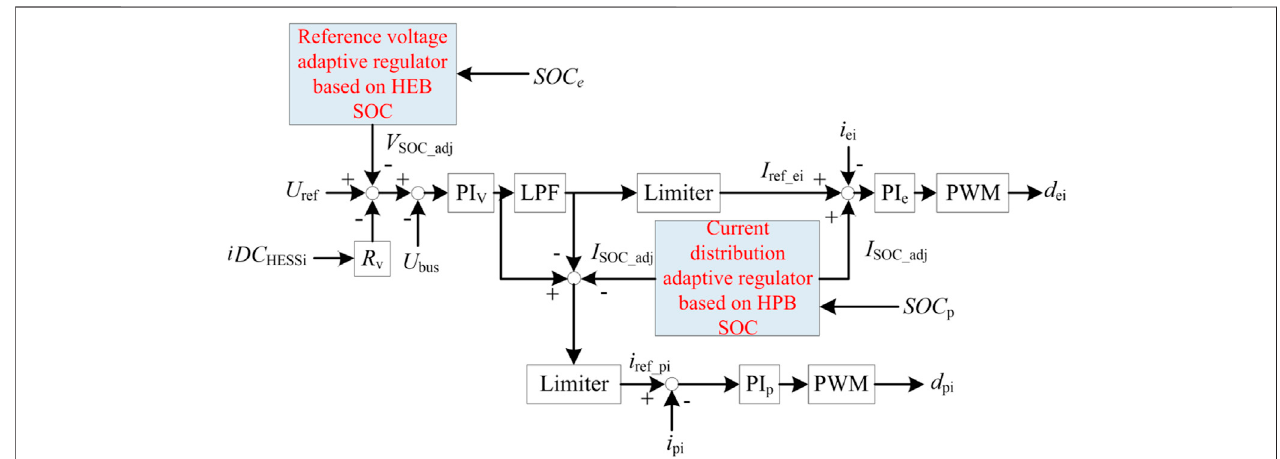
FIGURE 6 | The control structure diagram of